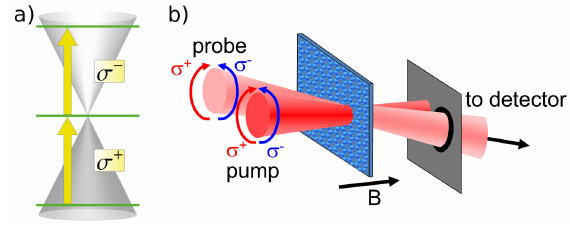
Figure 8: Circularly polarized differential transmission spec- troscopy. Sketch of the possible optical transitions of the ener- getically lowest Landau levels LL −1 , LL 0 and LL +1 (a), and the experi- mental setup to measure the differential transmission (b). Figure (b) is taken from Ref. [70] Copyright (2015) by Nature Publishing Group.